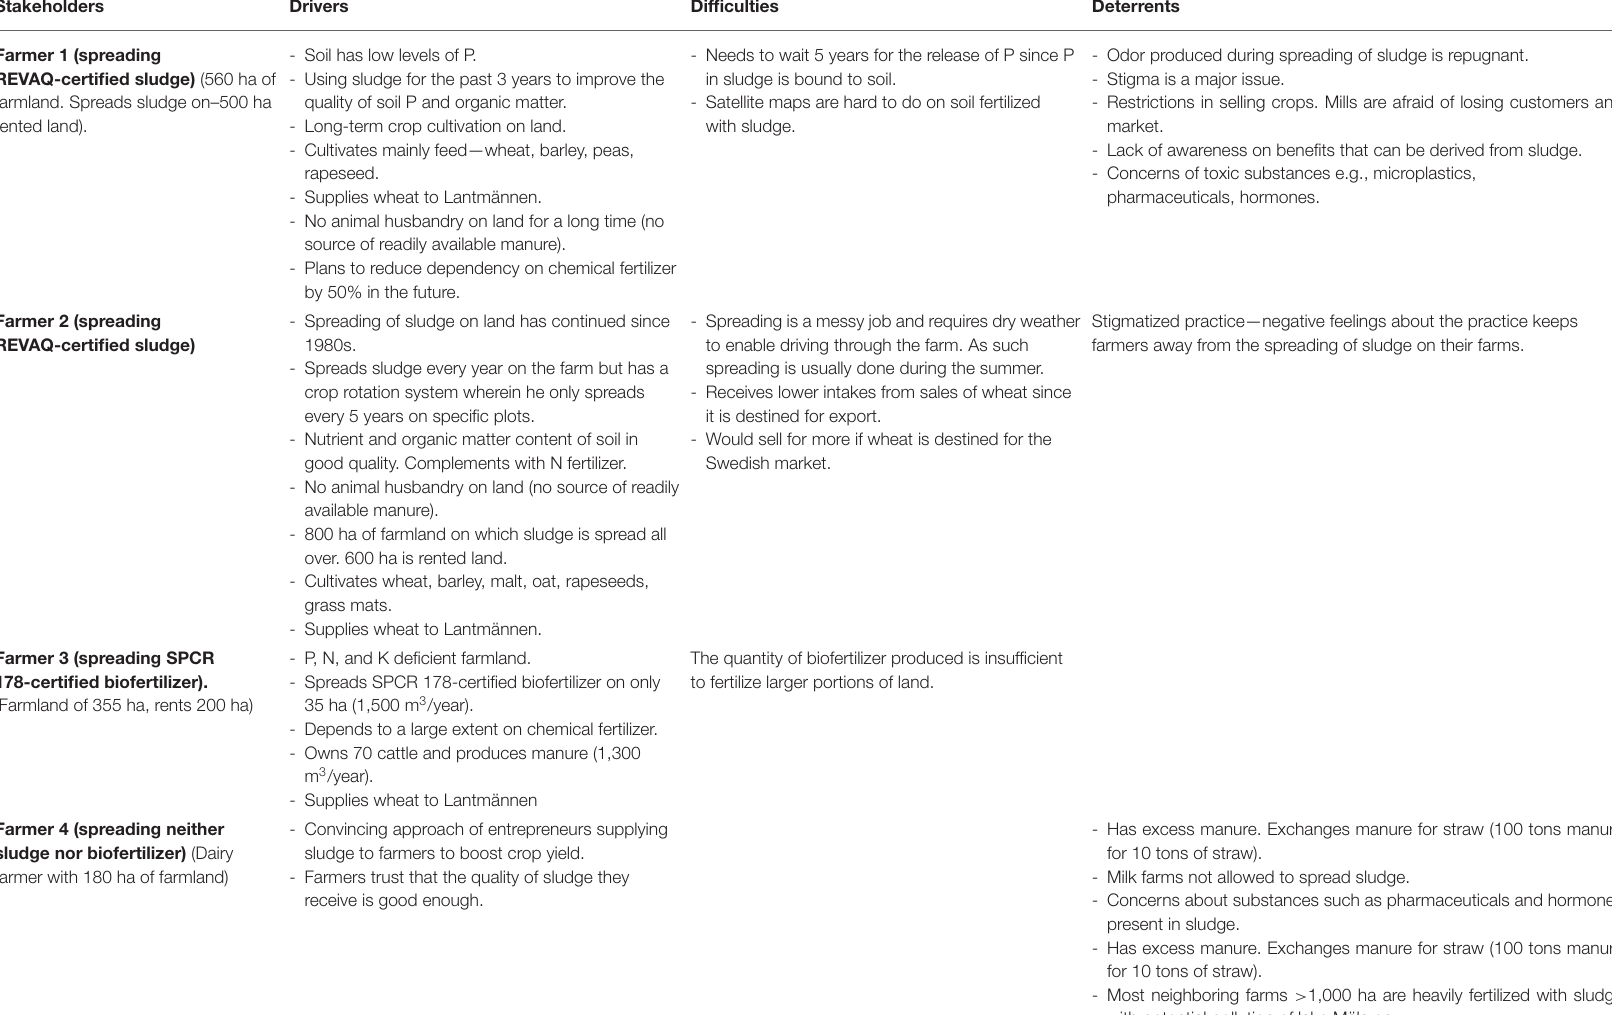
TABLE 4 | Drivers, difficulties, and deterrents of sewage sludge (REVAQ-certified) and biofertilizers (SPCR 178-certified). Stakeholders Drivers Difficulties Deterrents Farmer 1 (spreading REVAQ-certified sludge) (560 ha of farmland. Spreads sludge on–500 ha rented